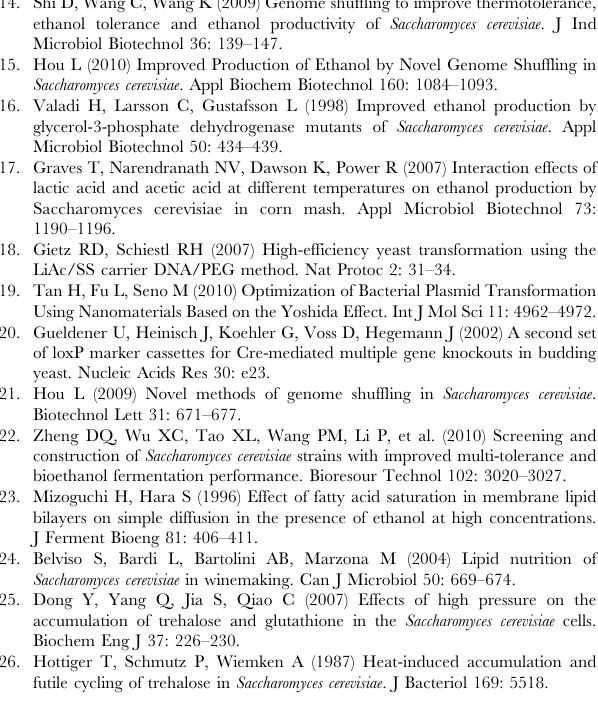
Figure S1 Trehalose content and cell viability of strain Z5,